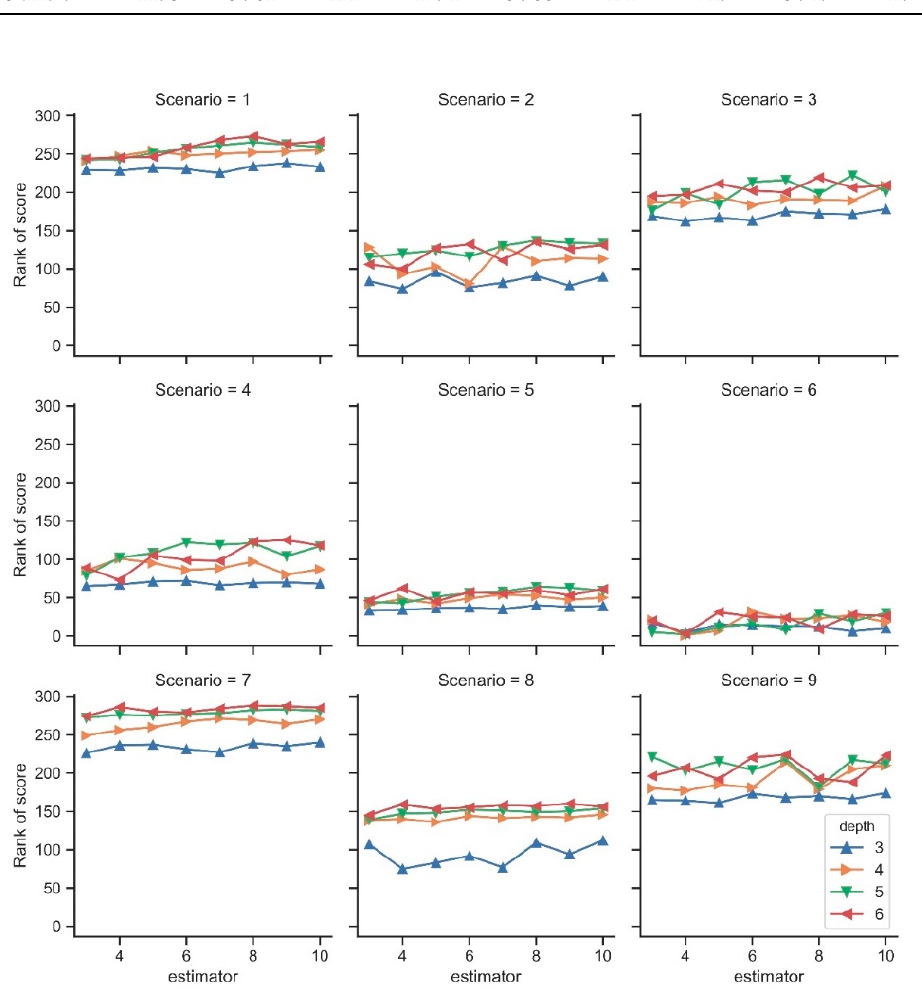
Figure 4. The rank of cross-validation scores for candidate parameter combinations.